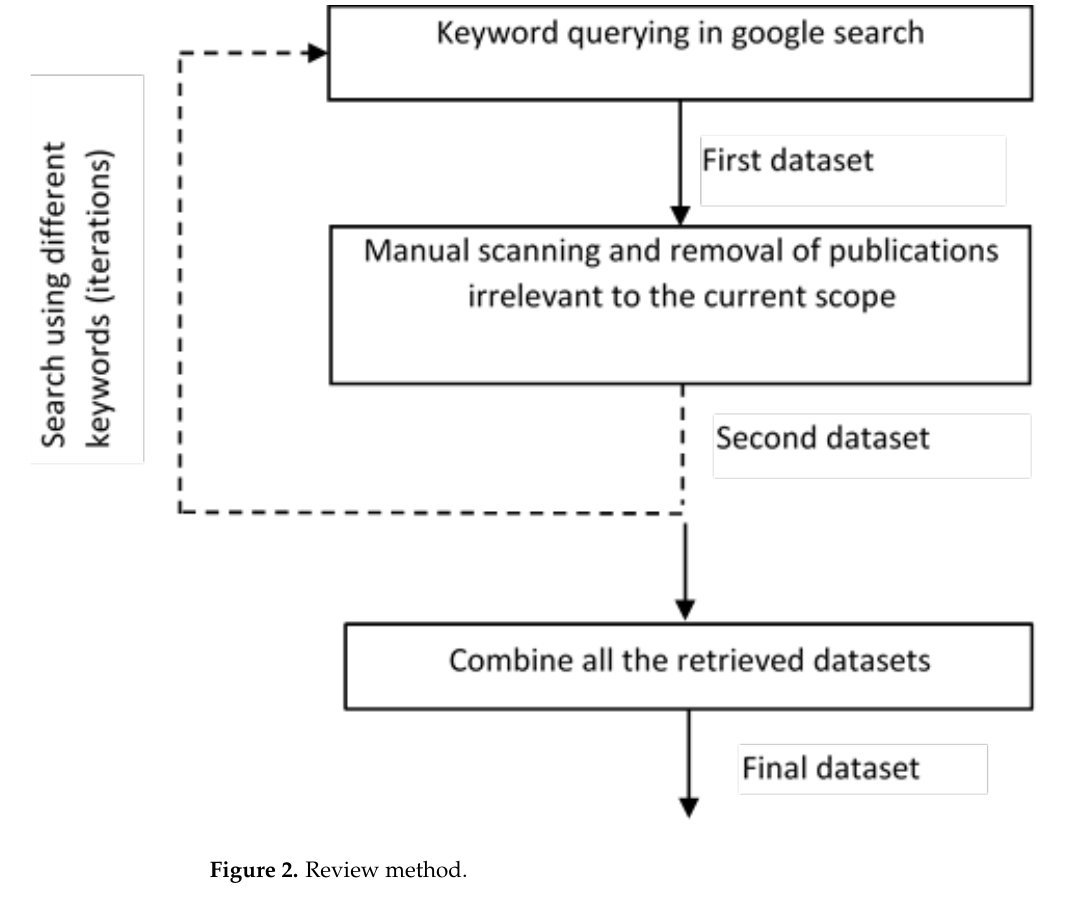
Figure 2. Review method.